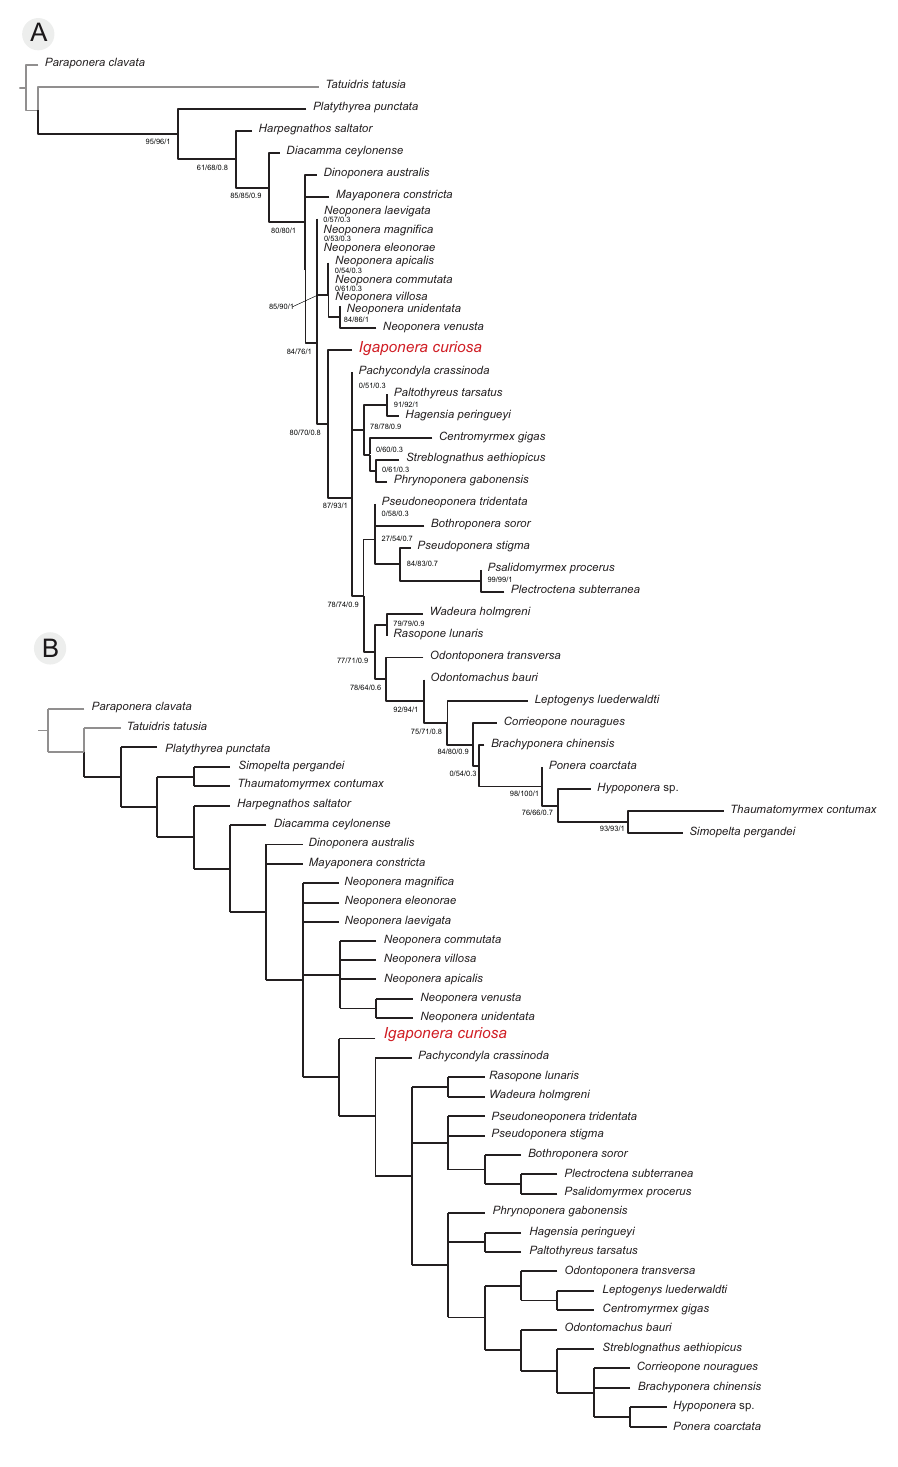
Fig. 1 . Morphology-based consensus phylogenies depicting the placement of Igaponera gen. nov. within the Ponerinae (Formicidae). The trees were inferred through: A . maximum likelihood in IQ-TREE, and B . maximum parsimony in TNT, using a data set composed of 36 characters and 38 terminals: 36 ingroup taxa, and two outgroups (branches in grey). The numbers next to nodes represent statistical support (SH- aLRT/Bootstrap/aBayes) and are only provided in the maximum likelihood tree (see Material and